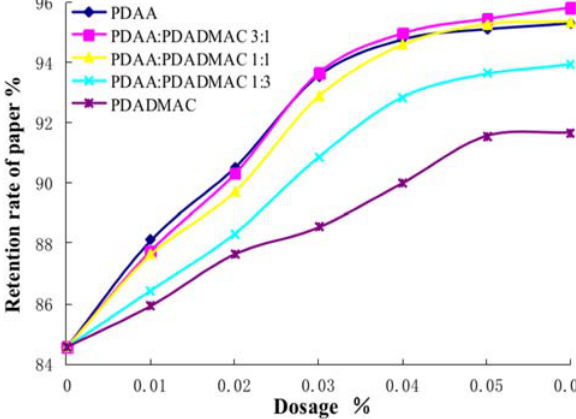
Figure 7: Synergistic retention of PDAA/PDADMAC. The molecular weight of PDAA is 4 million and the molecular weight of PDADMAC is 0.46